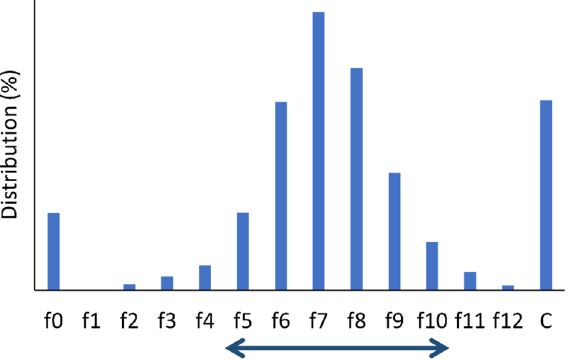
Figure 2. Radiochromatogram obtained during QMA-purification (f0: non-retaining fraction before elution, C: residual on the column). Fractions from f5 to f10 were